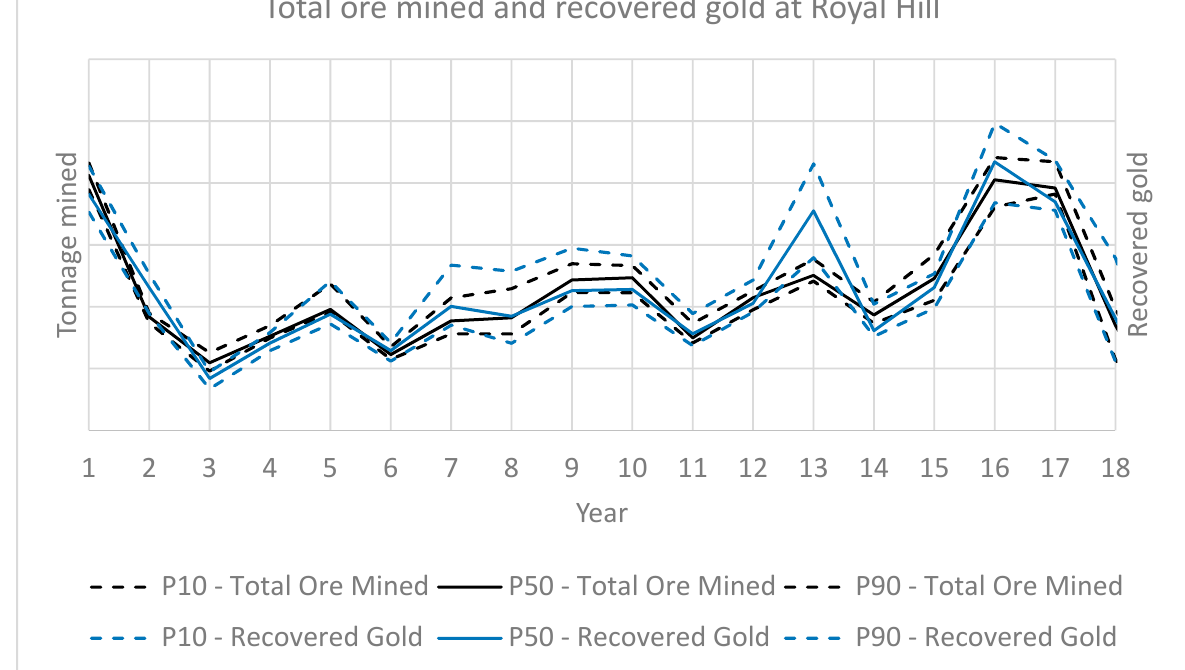
Figure 8. Ore tonnage mined and recovered gold at the Royal Hill Mine.